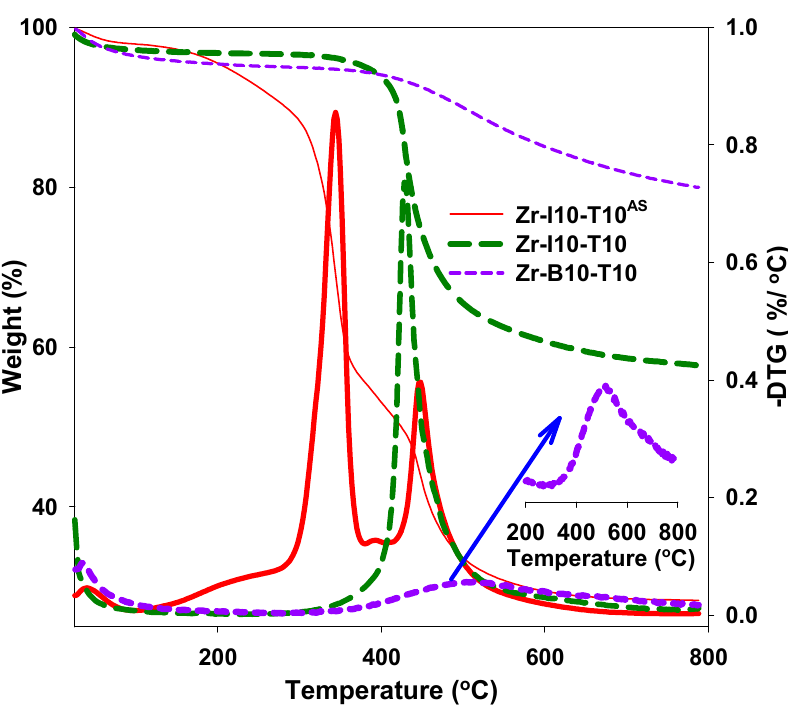
Figure 1. DTG curves for selected as-synthesized (AS), extracted, and thermally treated (350 ◦ C) Zr-I-PMO and Zr-B-PMO samples.